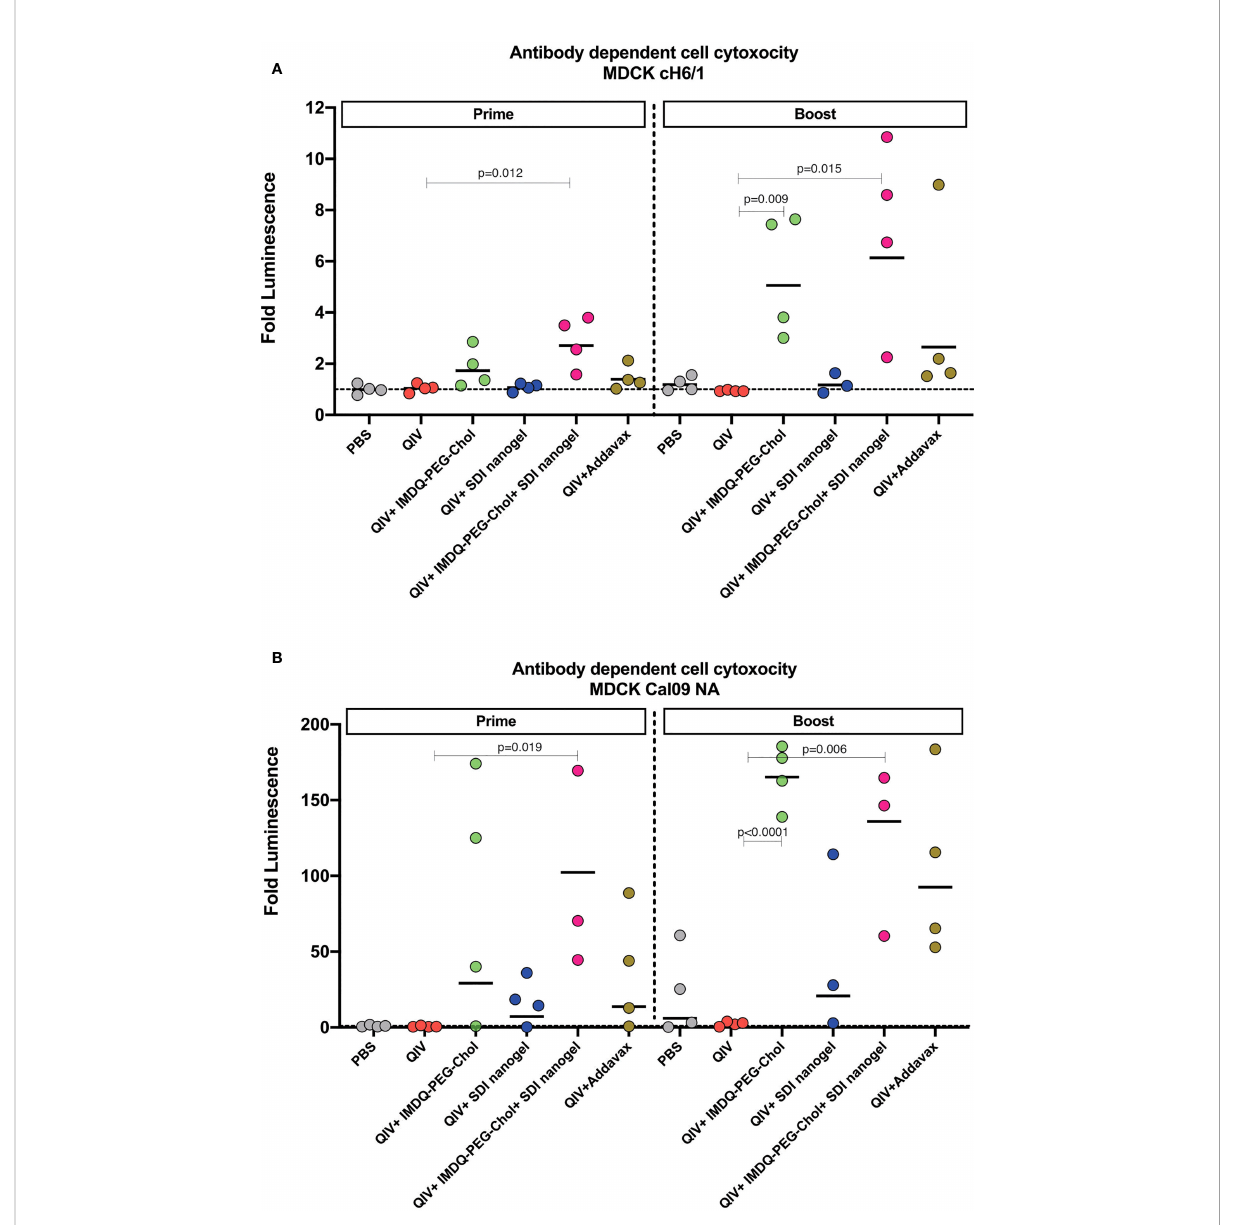
FIGURE 5 IMDQ-PEG-Chol enhances ADCC in vaccinated animals. Pre-seeded MDCK cells, stably expressing chimeric H6/1-HA (A) or Cal09-NA (B) , were incubated with post-prime or post-boost vaccination sera, followed by an incubation with effector Jurkat cells expressing Fc g IV receptors. The readout was in terms of luminescence which was used to calculate the area under curve (AUC) for each sample against antibody dilutions. The ADCC activity is represented as fold luminescence based on fold change in AUC for individual animal in all groups in reference to the PBS group. The line in each group represents geometric mean of fold Luciferase activity and each dot corresponds to individual animal in the respective group. Luminescence levels re fl ect Fc g R engagement and therefore are a surrogate for ADCC activity. Statistical analysis was performed using two-sided unpaired T test. P values are calculated in reference to respective unadjuvanted QIV